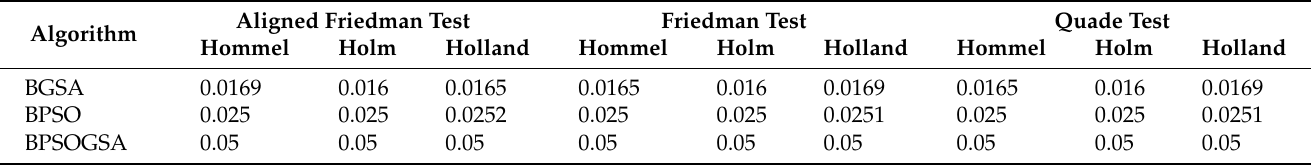
Table 3. p -value with significance level α = 0.05—KCET load.